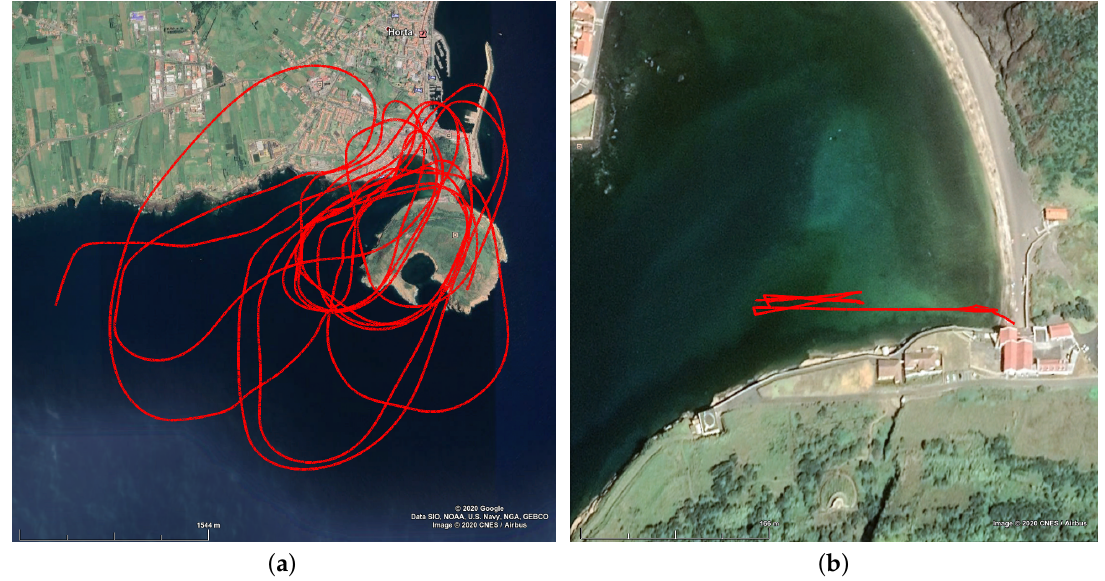
Figure 9. Flight trajectories: ( a ) shows the 20 September 2020 flight trajectory, performed by F-BUMA aircraft, while in ( b ) is possible to observe the trajectory of the 25 September 2020 flight performed with GRIFO-X